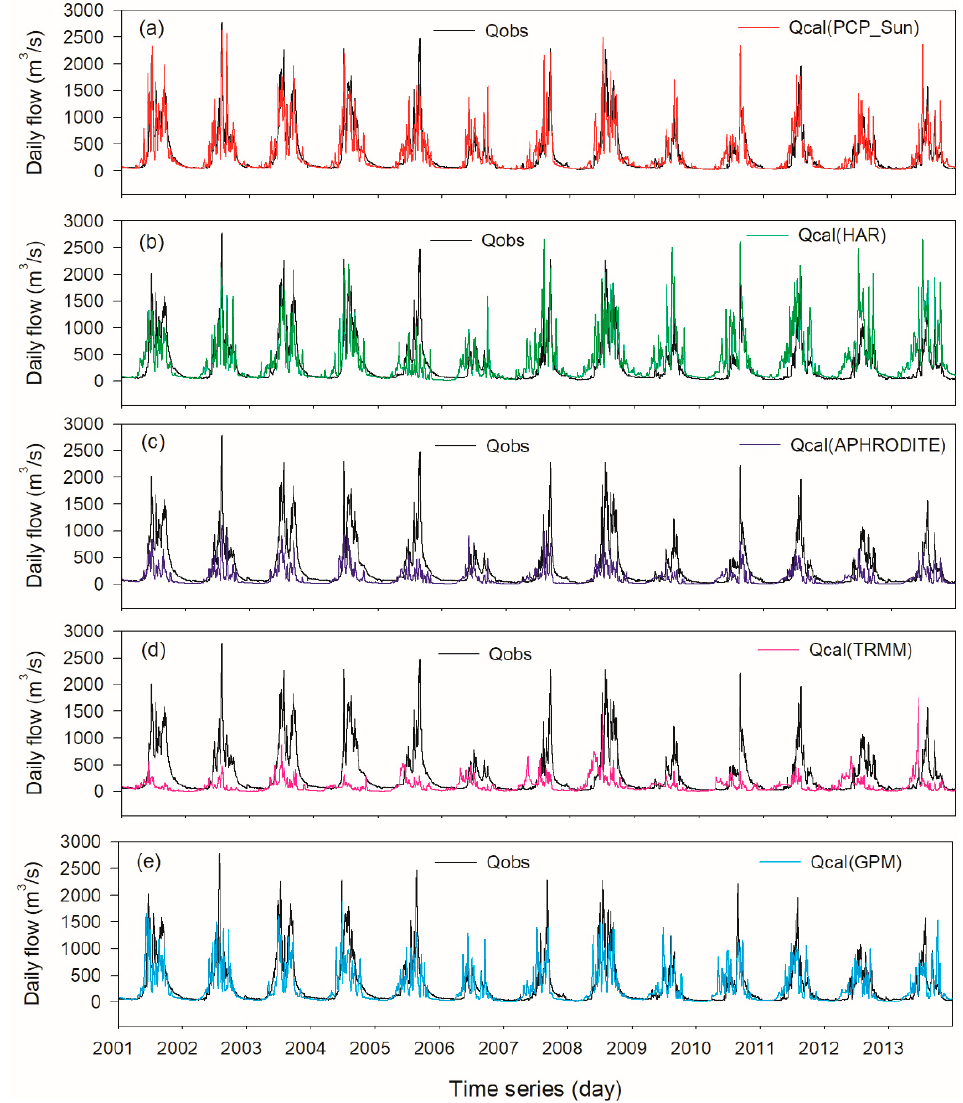
Figure 8. Daily flow simulation driven by ( a ) reference precipitation and four precipitation datasets: ( b ) HAR, ( c ) APHRODITE, ( d ) TRMM and ( e ) GPM, at Lhasa hydrological station during years 2001–2013.